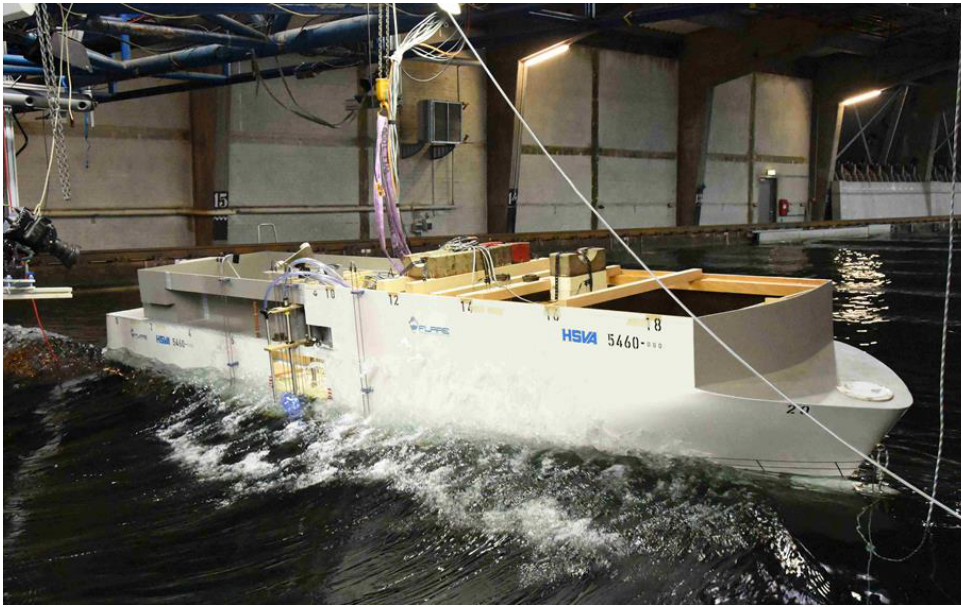
Figure 2. A model of a damaged RoPax ship in irregular beam seas in Hamburg Ship Model Basin HSVA.